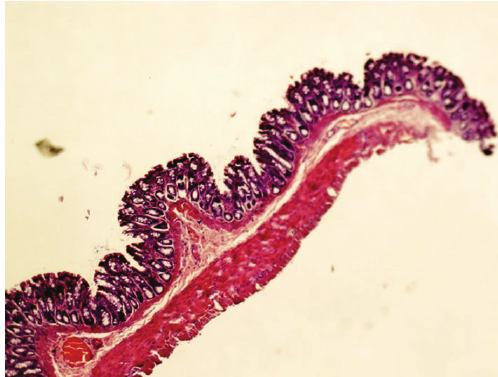
Figure 2: Normal crypt architecture and absence of inflammation seen in colonic mucosa from a rat in the NC